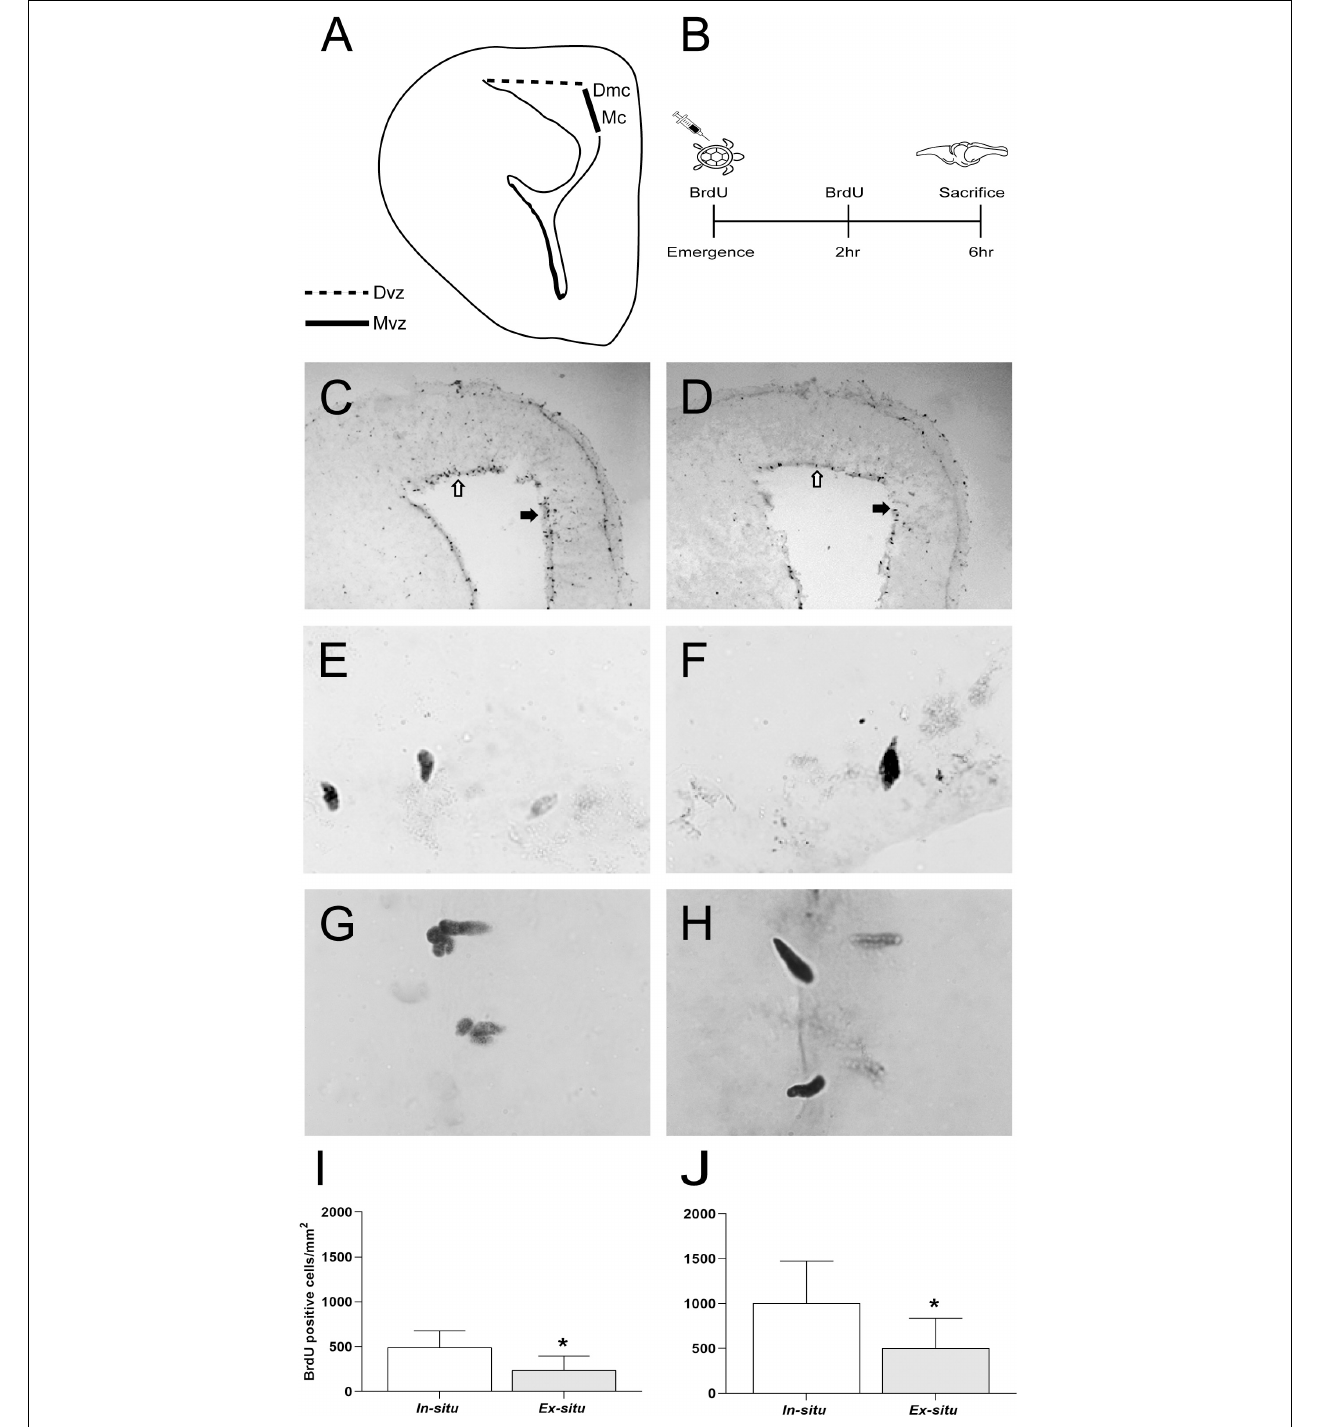
FIGURE 3 | Cell proliferation in neurogenic niches of L. olivacea hatchlings. (A) Schematic drawing of turtle brain hemi-section showing the dorsal (Dvz, dotted line) and medial ventricular zone (Mvz, continuous dark line), lining the lateral ventricle. (B) Timeline for 5 (cid:48) -bromo-2 (cid:48) -deoxyuridine (BrdU) pulse-chase protocol for cell proliferation analysis. (C,D) Representative brain sections showing BrdU + nuclei in the Dvz (open arrow) and Mvz (filled arrow) of one turtle from each condition ( in situ and ex situ , respectively). (E,F) Representative high magnification photographs showing BrdU + nuclei in the Dvz of one turtle from each condition ( in situ and ex situ , respectively). (G,H) Representative high magnification photographs showing BrdU + nuclei in the Mvz of one turtle from each condition ( in situ and ex situ , respectively). (I,J) Graphs showing the density of BrdU + nuclei. In situ ( n = 5), ex situ ( n = 5). Mean ± SD, Type III Analysis of Variance * p ≤ 0.05, scale bar = 200 µ m for panels (C,D) and 50 µ m for panels (E–H) .